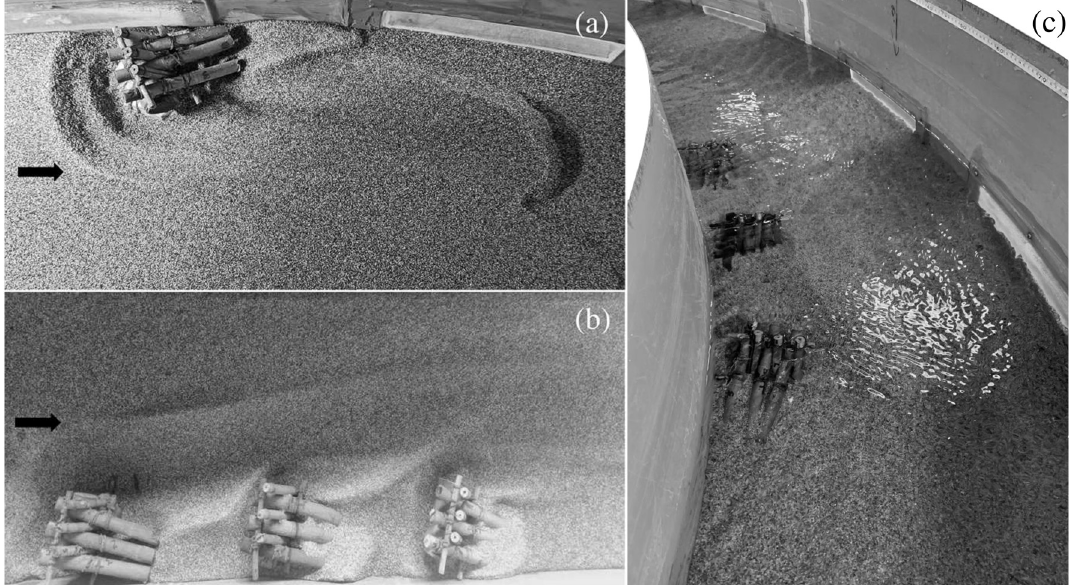
Figure 3. Equilibrium scour morphology in ( a ) curved and ( b ) straight channels. The black arrow shows the flow direction. ( c ) Curve of the channel, including a series of three structures during a test. The direction of the flow is from top to bottom. Table 1. Summary of experimental conditions and results.